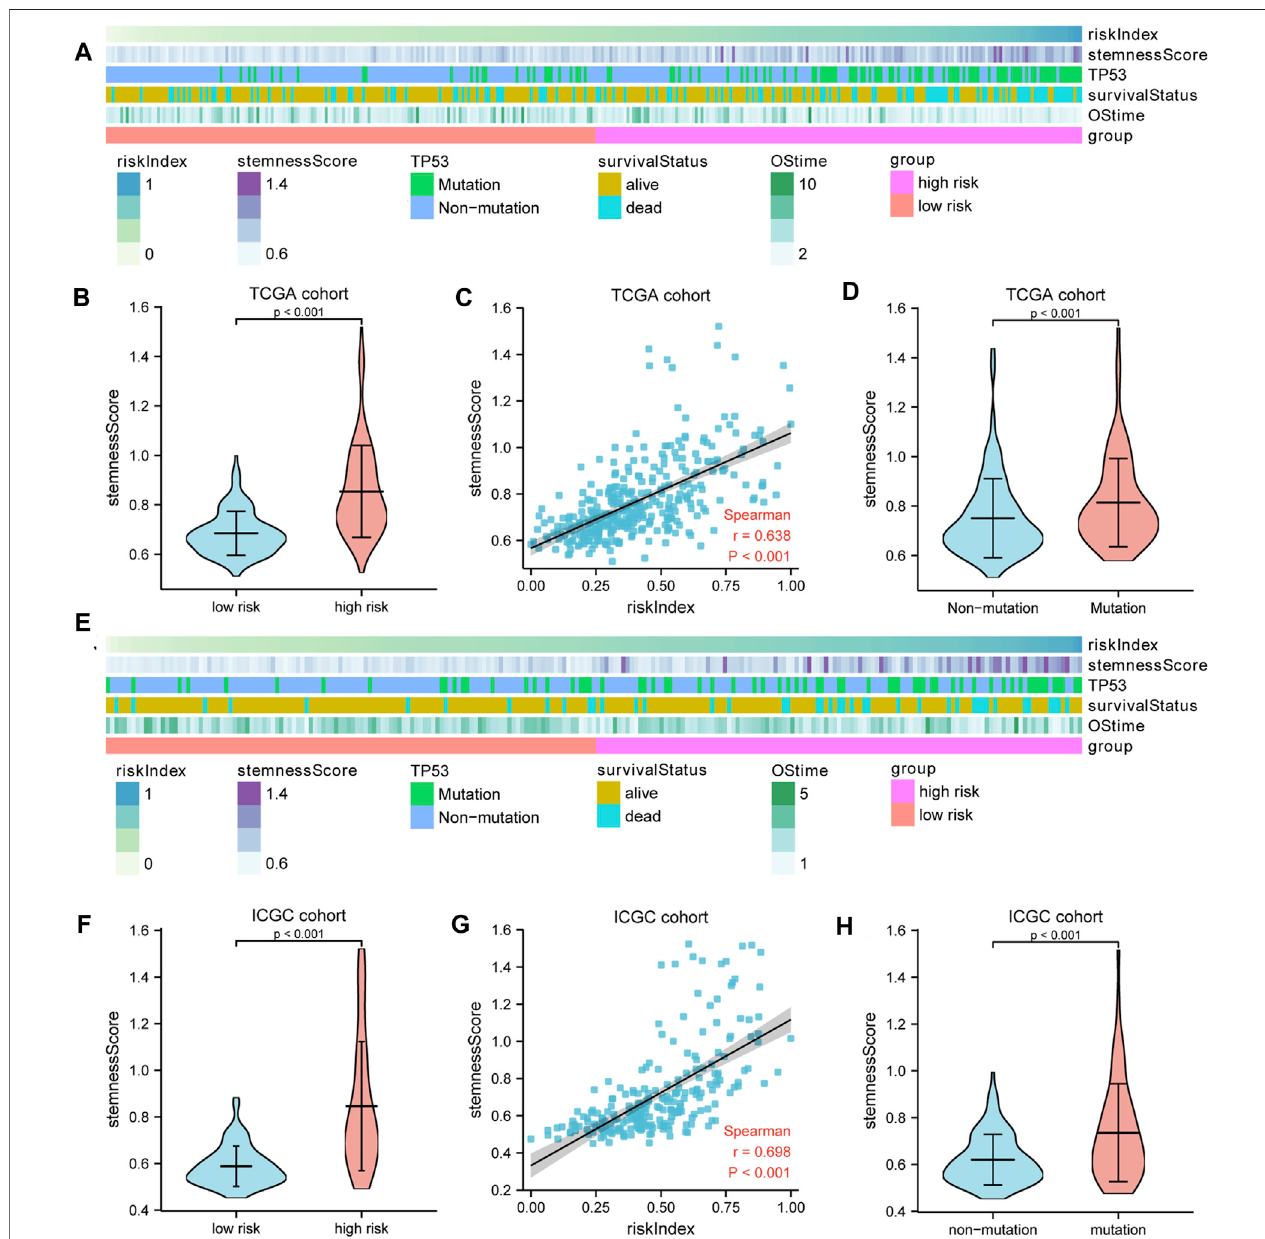
and stemness. A – D: TCGA cohort; E – H: ICGC